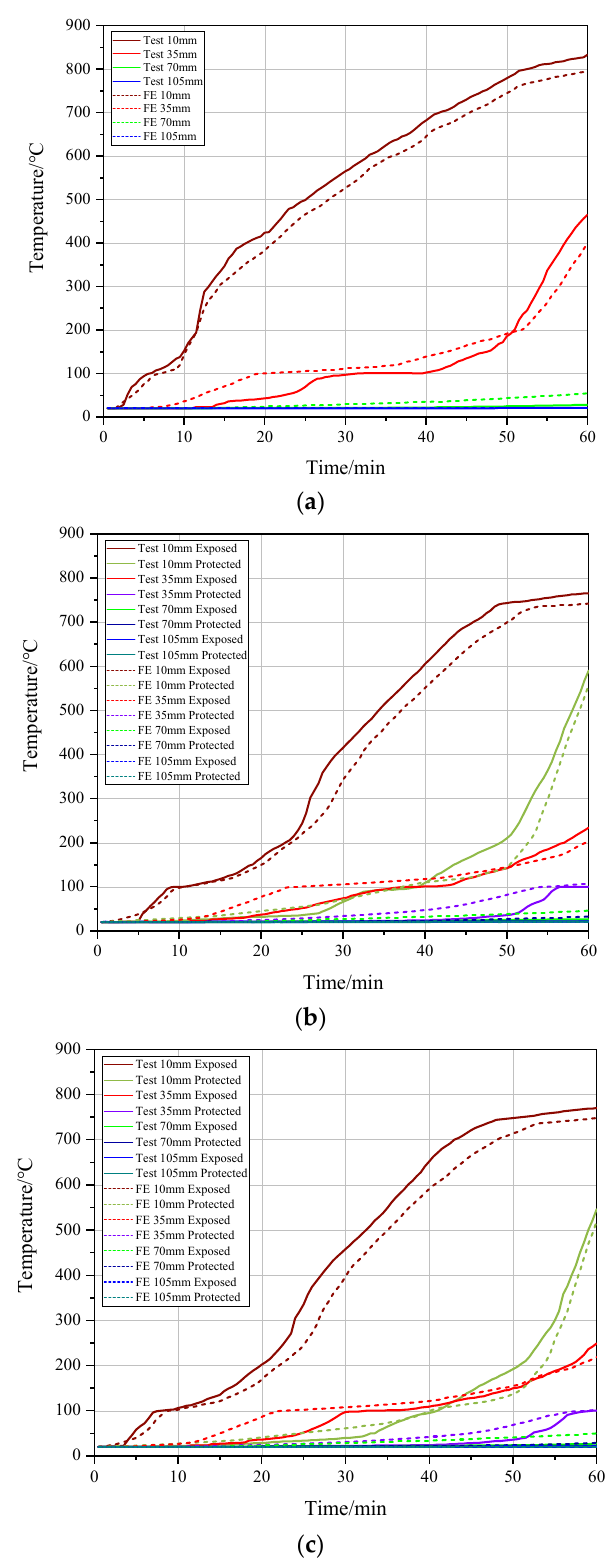
Figure 14. Comparison of the temperature test values and finite element values: ( a ) TCC1; ( b ) TCG2; and ( c )